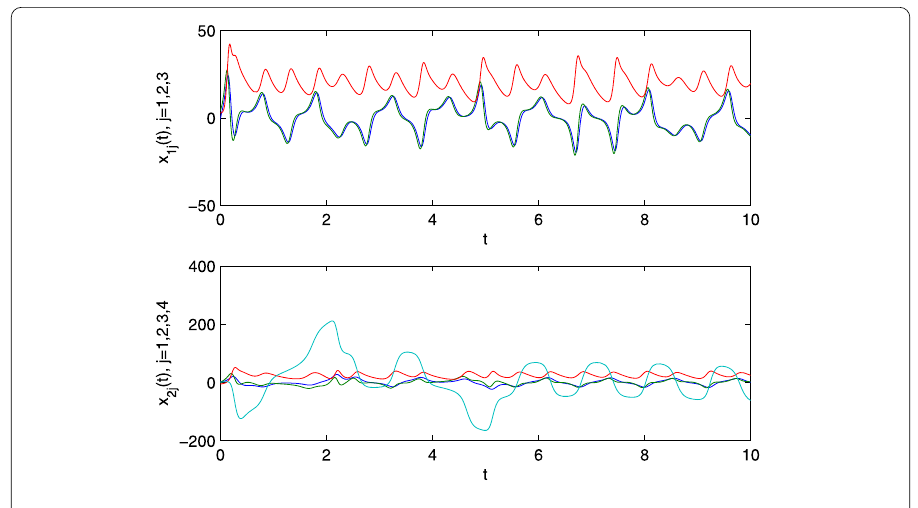
Figure 1 The state tracks of drive system (21)